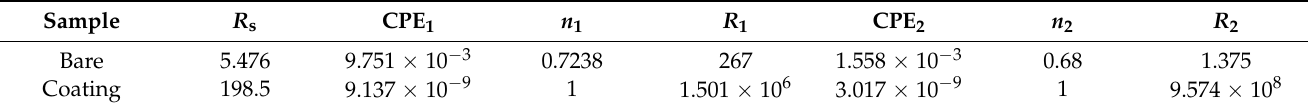
Figure 7. Average CA for different bending cycles. The mechanical durability of superhydrophobic coatings was evaluated through a series of mechanical durability tests. As shown in Figure 8a–c, the finger ‐ wiping test simulates the surface of the sample rubbed by a soft material. After three consecutive fingers rubbing the entire coating surface, the surface of the sample remains stable, and water droplets can quickly roll off from the surface of the sample (Video S1). However, the contact angle of coating B changed from 156.4° to 126.6° after the same test, so the mechanical durability of coating B was poor (Figure 8c inset). A putty knife was used to scrape the sample surface to simulate the sample being scraped by hard material, as shown in Figure 8d–f. After using the putty knife to scrape the coating surface four times continuously, the surface of the scraped sample does not fall off and remains superhydrophobic (Video S2). In order to test the performance of the superhydrophobic coating when subjected to external impact, the sample was subjected to a hammer test. A hammer was used to hammer the entire coating several times until the entire substrate was deformed to ensure that the entire coating surface was hammered. As shown in Figure 8g–i, the hammered sample was deformed, but the sample maintained its superhydrophobicity, confirming the solid and stable microstructure of the sample surface after external damage (Video S3). In order to further verify the mechanical durability of the samples, a utility knife was used to cut the superhydrophobic coating. The simulative coating was damaged by sharp objects. A utility knife was used to scratch the surface of the coating several times in two different directions to make grid ‐ like scratches appear on the entire coating surface. As shown in Figure 8j–l, the